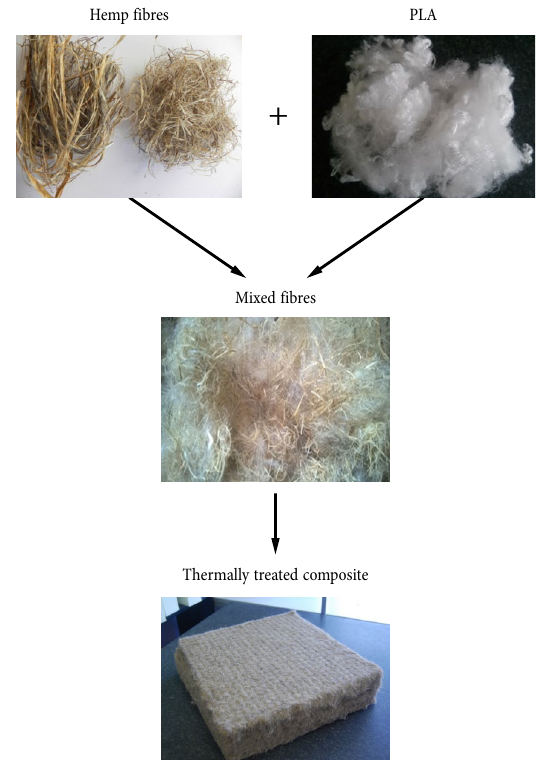
Fig. 1. The principal scheme of composite